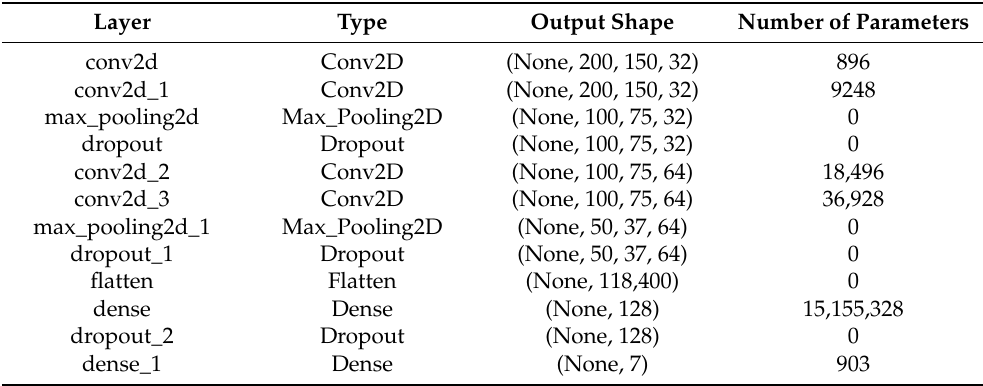
Table 1. Summary and overall architecture of the CNN model used in this